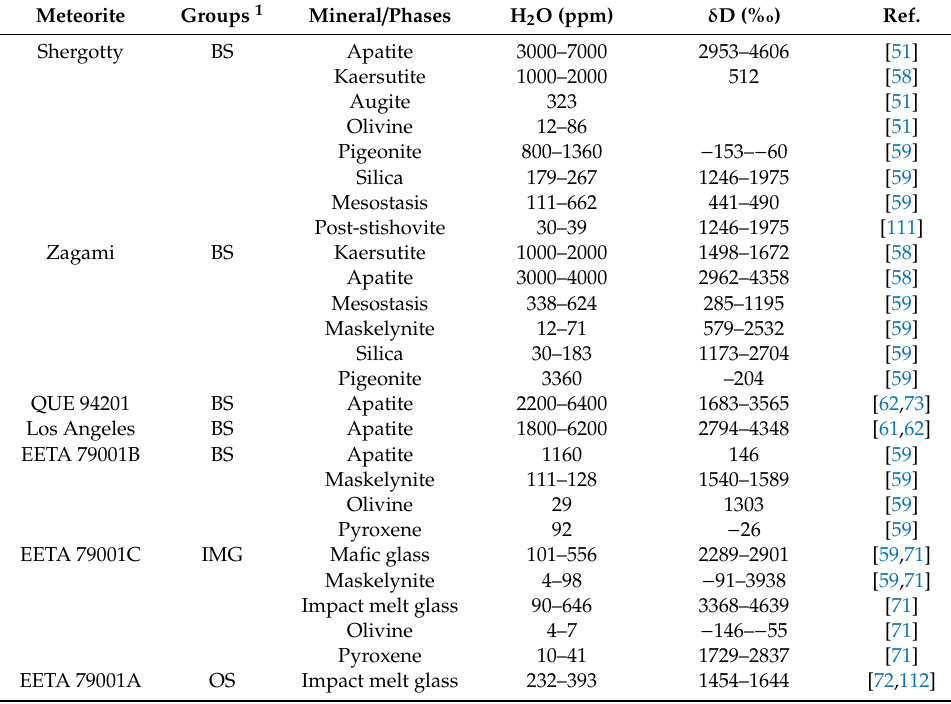
Table 1. A summary of water content and H isotopes analysis of